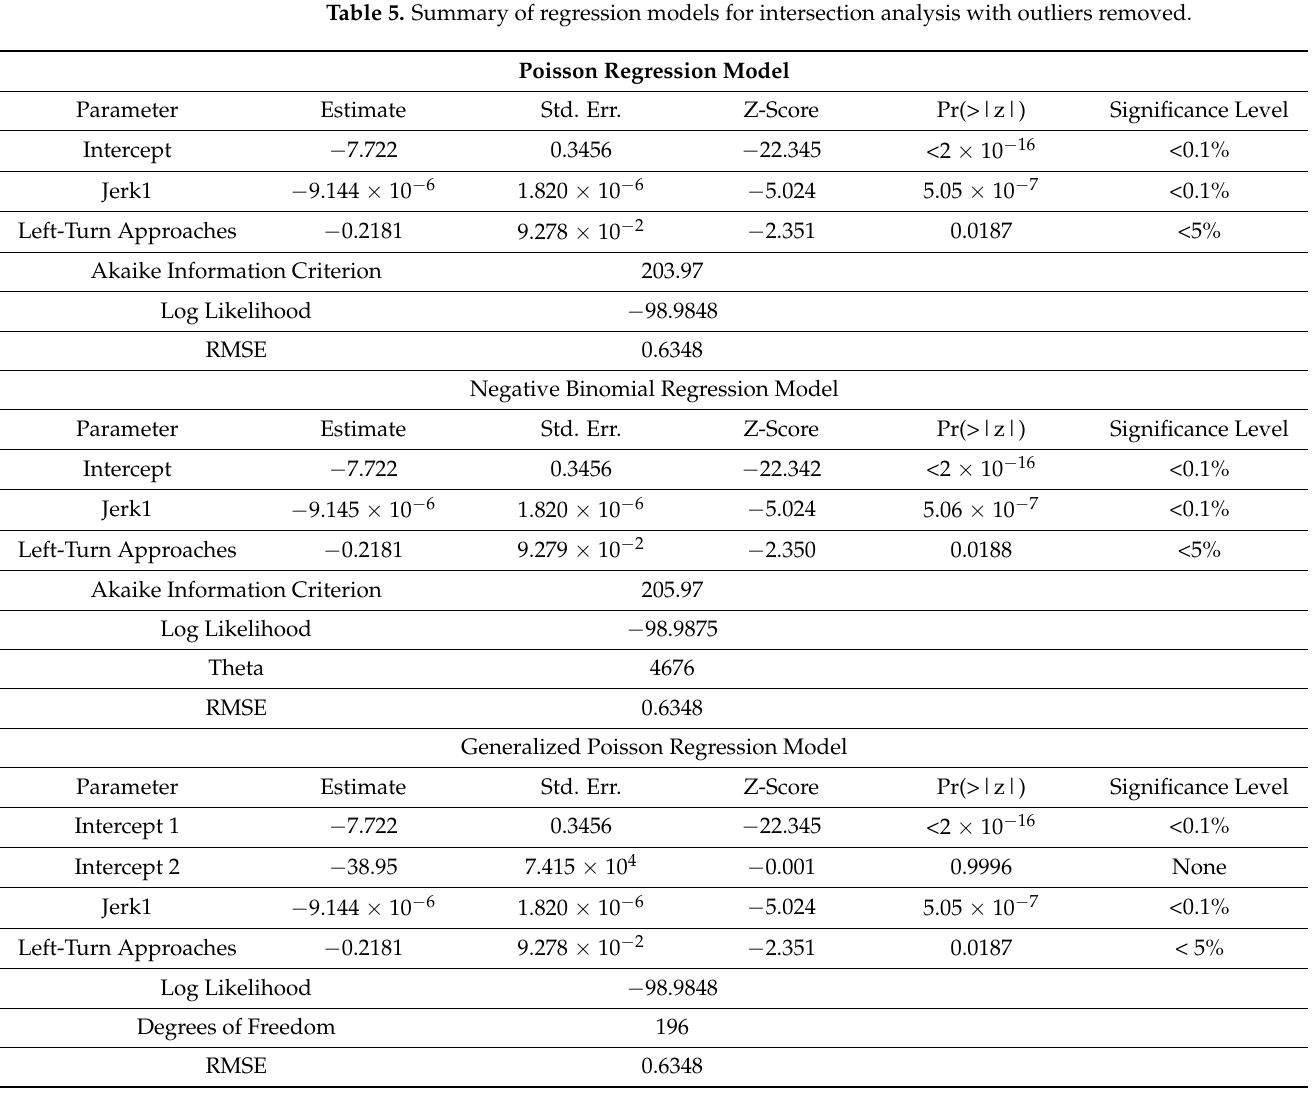
Table 6. Summary of regression models for segment analysis with outliers removed. Poisson Regression